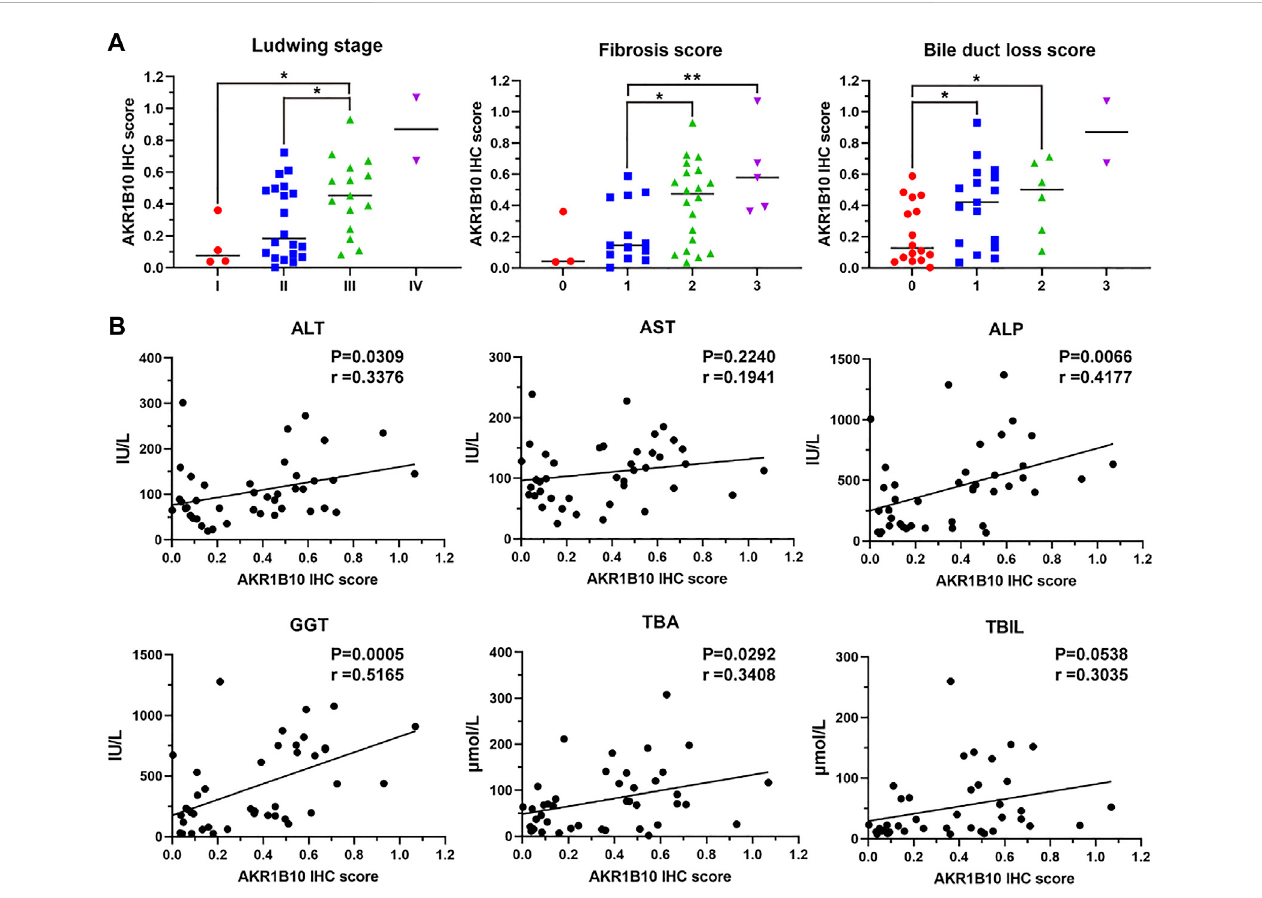
FIGURE 8 Relationship between hepatic AKR1B10 expression and clinicopathological characteristics in patients with PBC. (A) The relationship between hepatic AKR1B10 expression and the Ludwig stage, degree of fi brosis, and bile duct loss scores in patients with PBC. Plotted: Mean ± S.D.; Statistics: one-way analysis of variance (ANOVA); * p < 0.05. (B) The correlations between hepatic AKR1B10 expression and clinicopathological features in patients with PBC. Statistics: Pearson ’ s correlation analysis. AKR1B10, aldo-keto reductase family 1 member B10; PBC, Primary biliary cholangitis; ALT, alanine aminotransferase; AST, aspartate aminotransferase; ALP, alkaline phosphatase; GGT, gamma-glutamyl transferase; TBA, total bile salts; TBIL, total